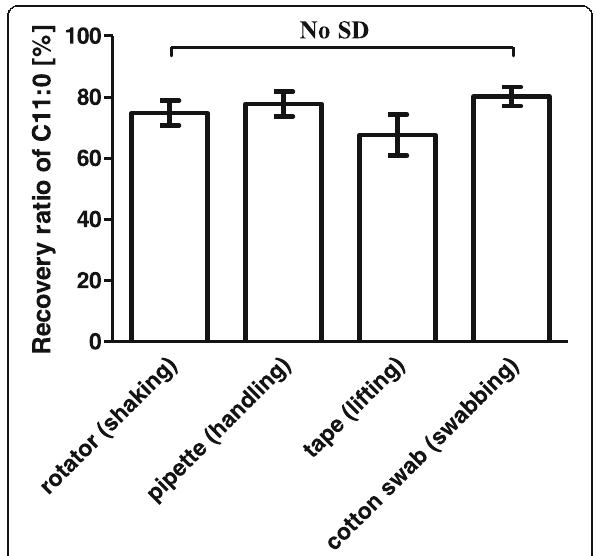
Fig. 9 Recovery ratio of C11 using different treatment methods (% of total fatty acids n = 8). “ No SD ” means there is no significant difference